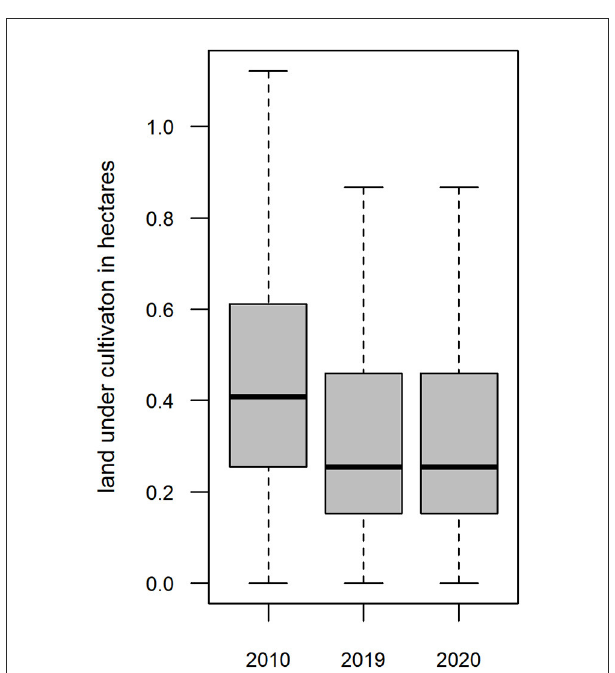
FIGURE4 Land under cultivation. Households total land under cultivation has declined since 2010 on average (10 years before our survey) amidst growing investment in off-farm employment. Several households (20 out of 240) report small increases in productive land between 2019 and 2020, however this change is marginal and is not perceptible in the